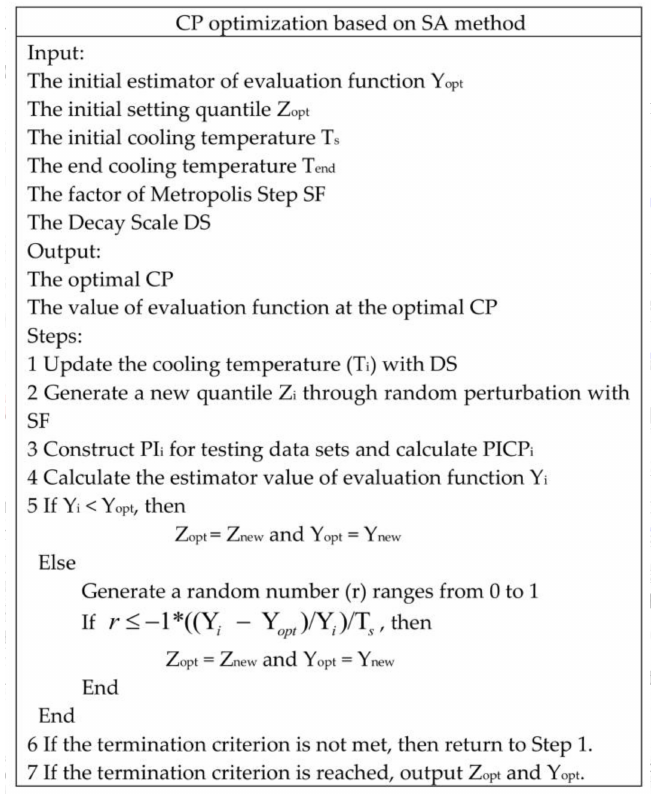
Figure 7. CP optimization based on simulated annealing